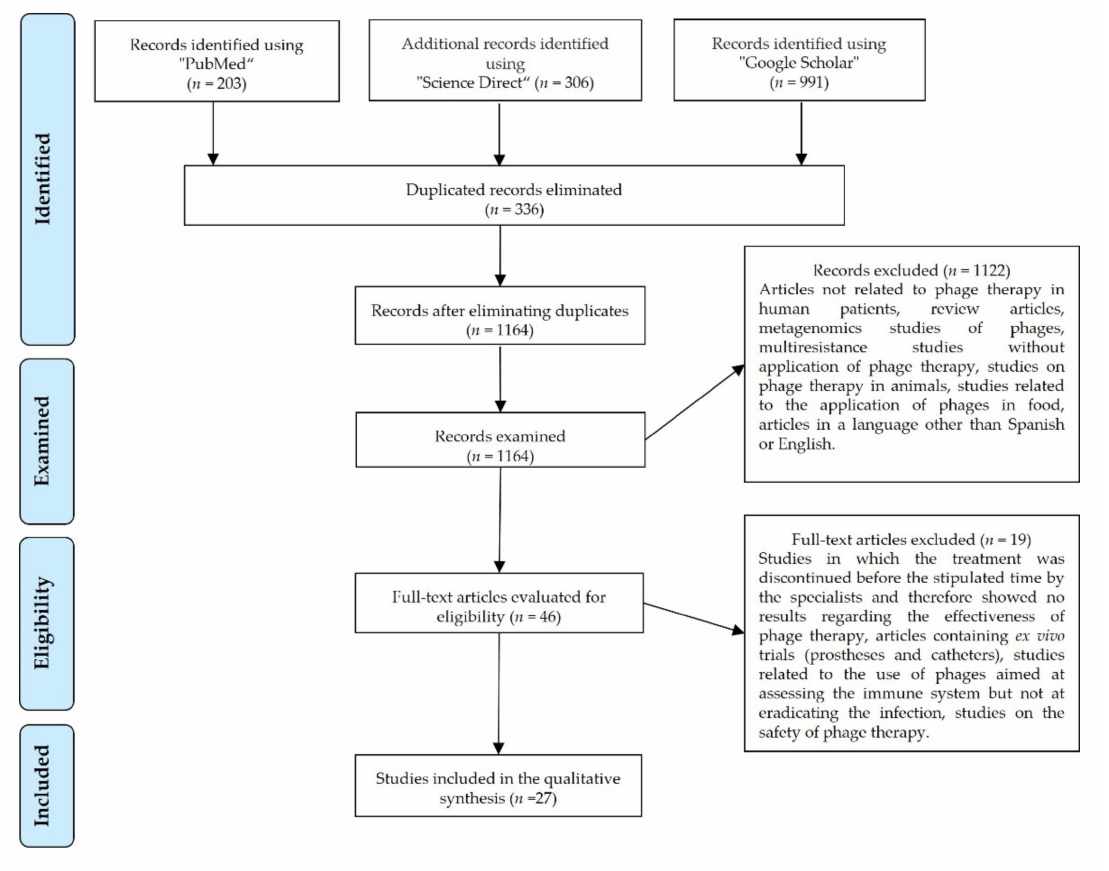
Figure 1. PRISMA flowchart illustrating the search and selection of the